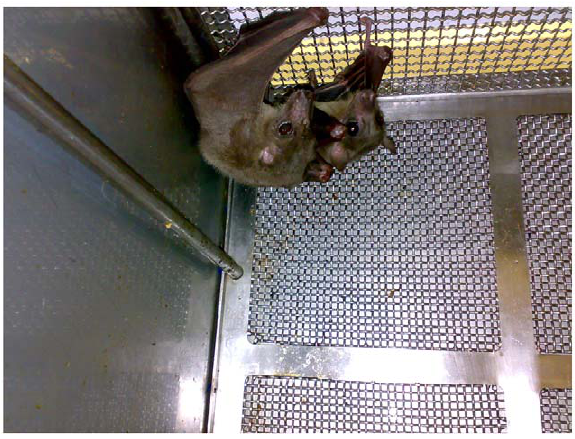
Figure 2. Custom-made experimental bat cage, which allows for housing 2–4